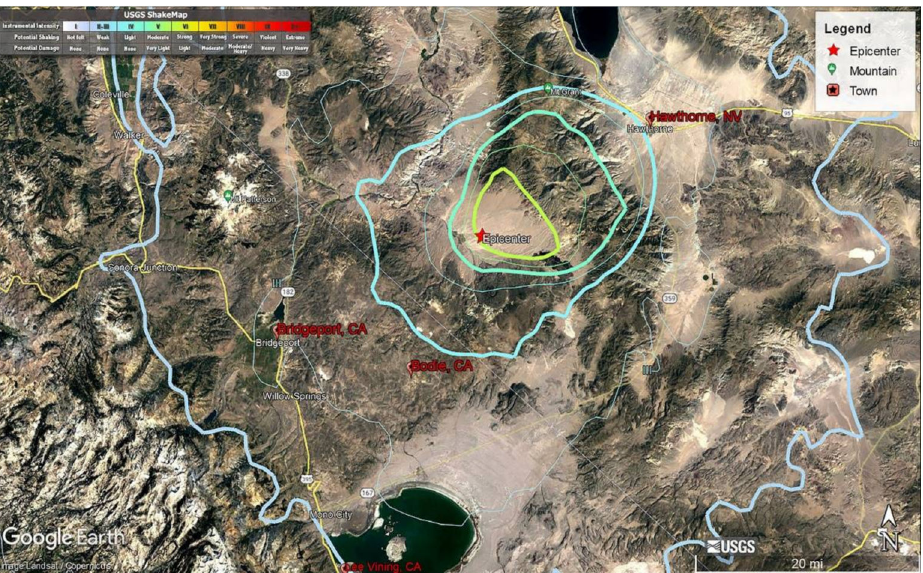
Figure 7. Map showing the epicenter location and intensity contour lines of the 5.6 M earthquake that affected Bodie’s region in December 2016. Generated from data made available by USGS and Google Earth Pro v.7.3.4.8248 (22 February 2014). Epicenter 38 ◦ 23 (cid:48) 25.44 (cid:48)(cid:48) N, 118 ◦ 53 (cid:48) 49.92 (cid:48)(cid:48) W, Eye alt 74.25 miles. Data CISN:NCSS, Nevada Seismological Laboratory, USGS NEIC. Image Land- sat/Copernicus. Google 2021. http://www.earth.google.com (accessed on 15 August 2021). Map by N.